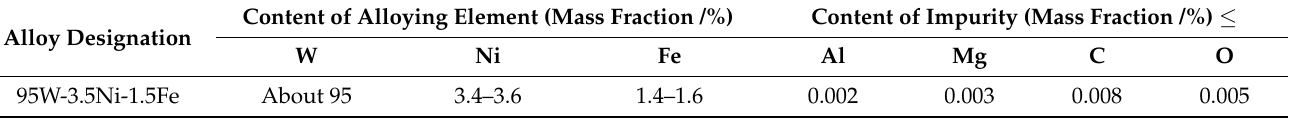
Table 1. Components of tungsten